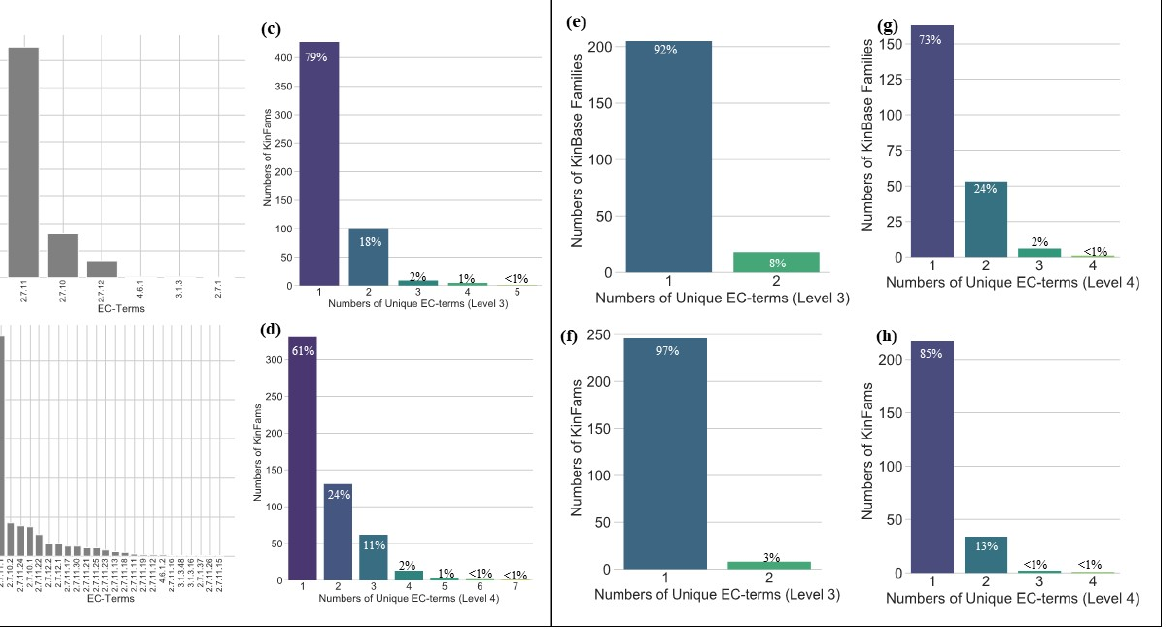
Figure 6. Distribution of EC-terms at levels 3 ( a ) and 4 ( b ) found in the KinFams for the complete set of 330,085 sequences classified in KinFams. Numbers of KinFams with one or more EC at level 3 ( c ) and EC at level 4 ( d ) in KinFams. It can be seen from Figure 6c,d that the majority of KinFams are associated with one EC3 and one EC4 term. For a subset of sequences in KinFams that map to KinBase, the right panel of the figure compares the numbers of unique EC terms at level 3 for KinBase ( e ) and KinFams ( f ) and level 4 for KinBase ( g ) and KinFams ( h